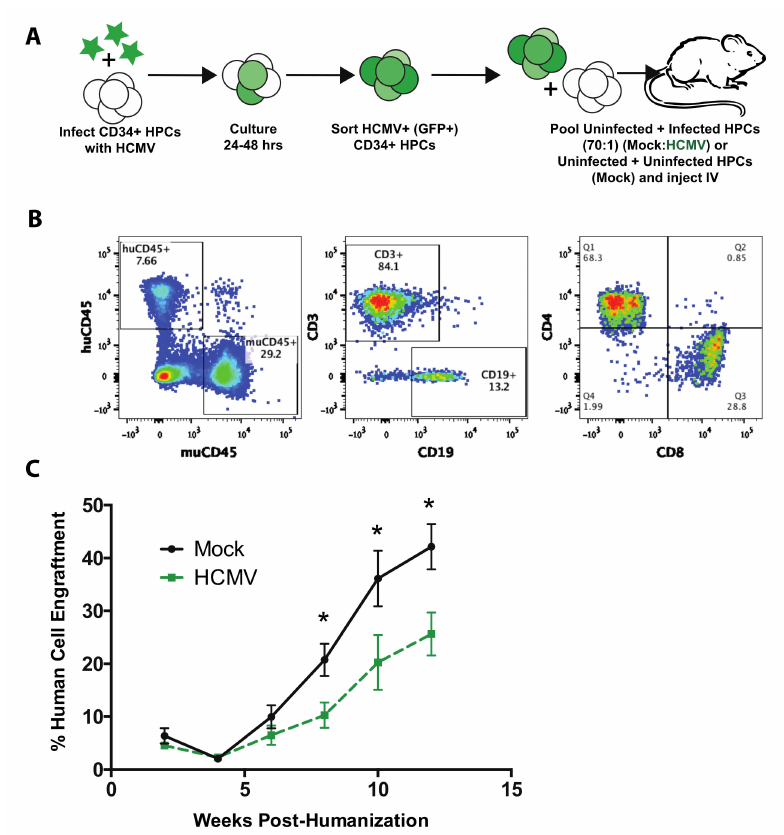
Figure 2. HCMV infection suppresses CD34 + HPC engraftment in huBLT mice. ( A ) huBLT (bone-marrow–liver–thymus)-NSG mice were generated by transplantation of human fetal liver and thymus under the kidney capsule of adult NSG mice. Post-surgical transplant, mice were sub-lethally irradiated and intravenously (IV) injected with autologous human CD34 + hematopoietic progenitor cells (HPCs). All huBLT mice were IV-injected with autologous human CD34 + HPCs at 4.2e5 cells per mouse. HCMV-infected huBLT mice were generated by pre-infection of a subset of CD34 + HPCs with wild-type HCMV (TB40 / E-GFP) for 24 hrs. Infected cells were sorted by FACS for viable, CD34 + GFP + cells and mixed with uninfected cells (at a 1:70 ratio: 6e3 infected HPCs plus 4.2e5 uninfected HPCs per mouse) prior to injection (HCMV). A control population was mock-infected and sorted in the same manner to generate the uninfected group (Mock). n = 7 per group. (B) Mice were bled every two weeks post-humanization and screened for human cell engraftment by flow cytometry using antibodies specific for huCD45, huCD3, huCD19, huCD4, huCD8, and muCD45. A representative flow cytometry gating strategy is shown. Panel 1: huCD45 vs. muCD45 leukocytes (gated on total viable leukocytes); Panel 2: CD3 + T-cells vs. CD19 + B-cells (gated on huCD45 + cells in panel 1); Panel 3: huCD4 + and huCD8 + T-cells (gated on huCD3 + T-cells in panel 2). Data shown are of an uninfected (Mock) mouse at 10 weeks post-humanization. ( C ) Time-course of human CD45 + leukocyte engraftment overtime. Data shown are the average of the total percentage of huCD45 + lymphocytes and monocytes out of all CD45 + lymphocytes and monocytes (huCD45 + plus mouse CD45 + ), gated on viable cells for each group. Error bars represent standard error of the mean, *: p <